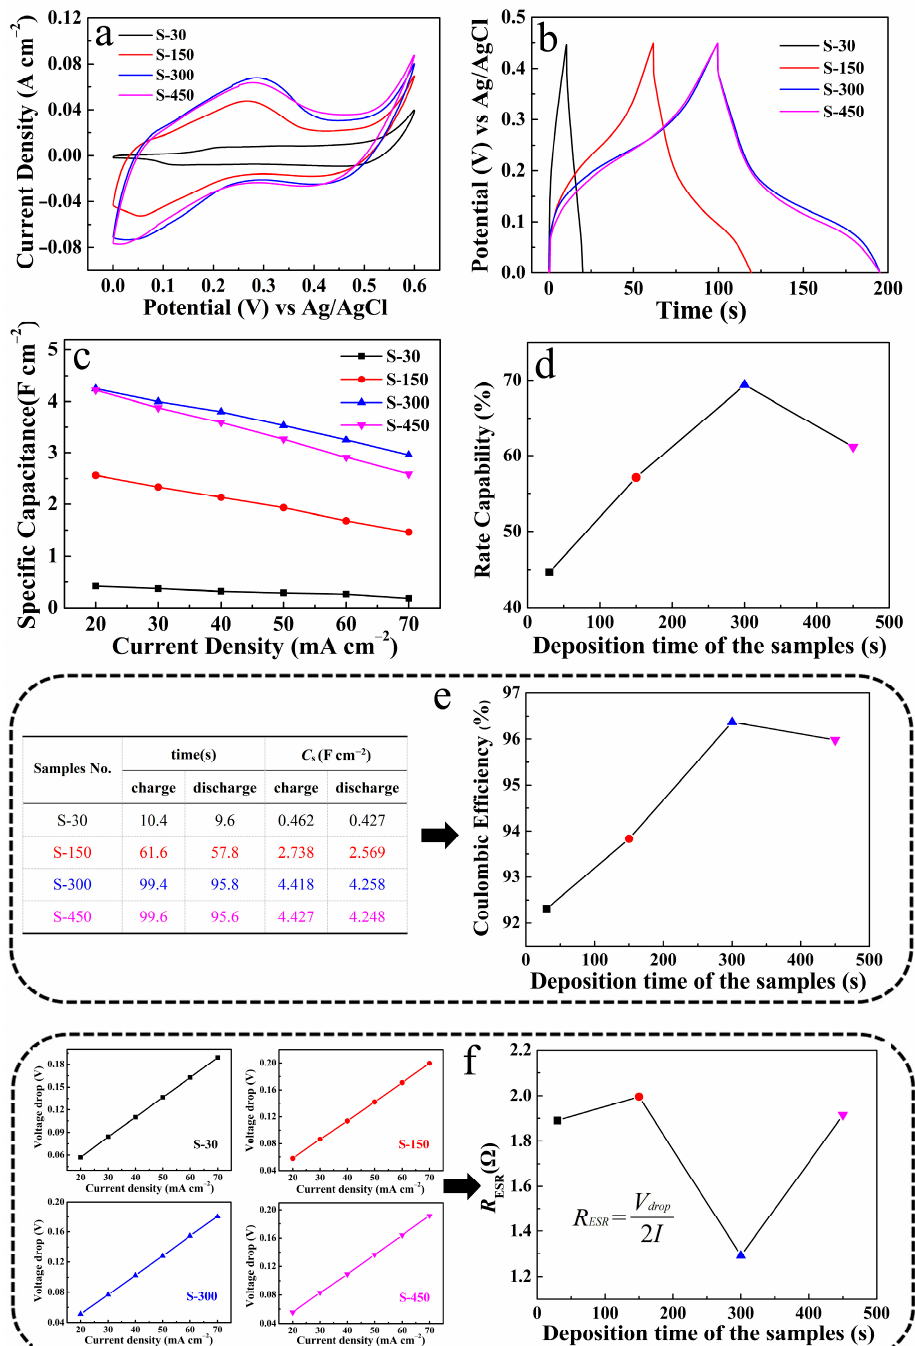
Figure 8. Comparison of energy storage properties of CuO/NCS electrodes with different NCS deposition times (S-30, S-150, S-300, and S-450): ( a ) CV curves; ( b ) GCD curves; ( c ) C s at different current densities; ( d ) rate capability; ( e ) coulombic efficiency; and ( f ) average R ESR